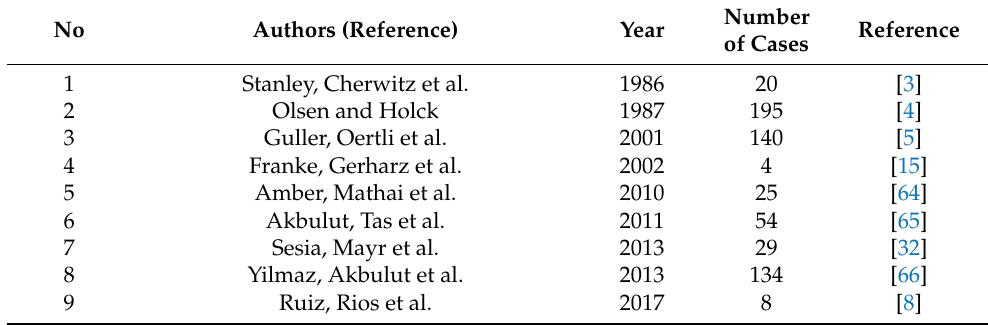
Table 2. Previous case series of neurogenic